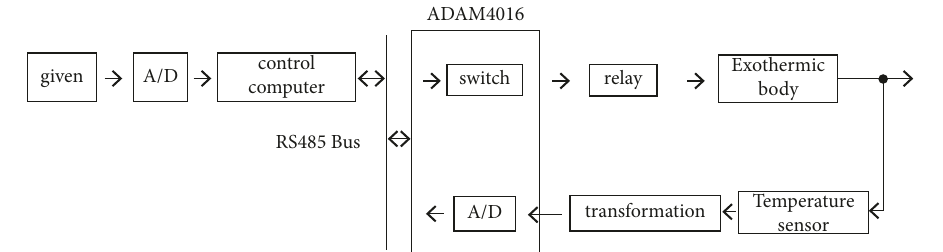
Figure 5: Structure diagram of temperature control system.